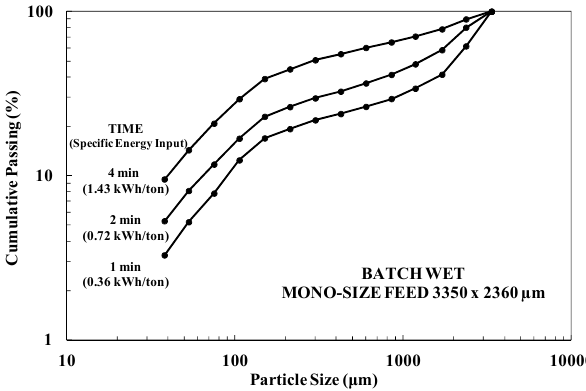
Figure 3. Experimental product size distributions from batch test with material contained in 3350– 2360 μ m size range. Tests at 72% solids concentration, 100% of slurry filling, 40% of ball filling, and 68.3% of critical speed.